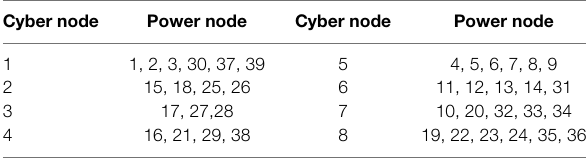
TABLE 1 | Cyber nodes connected to the power nodes. Cyber